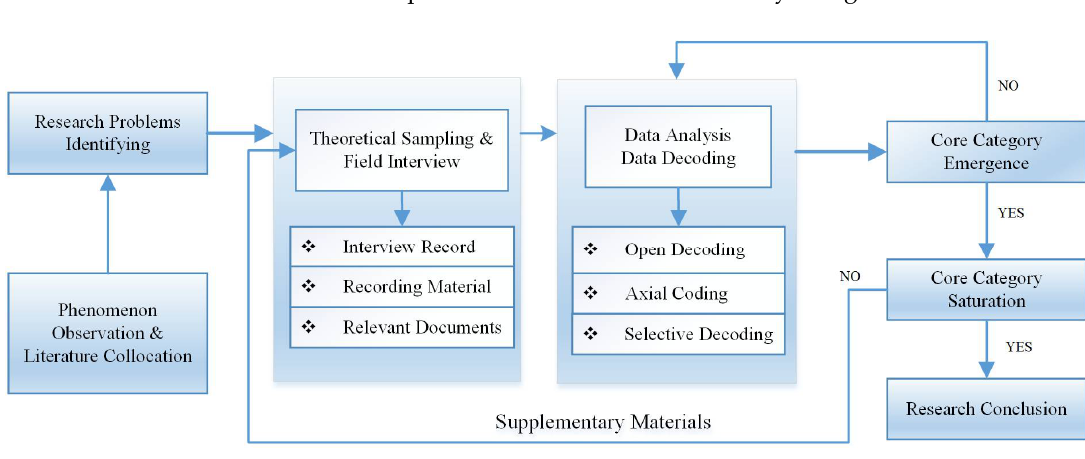
Figure 1. Encoding process and overall qualitative research method.